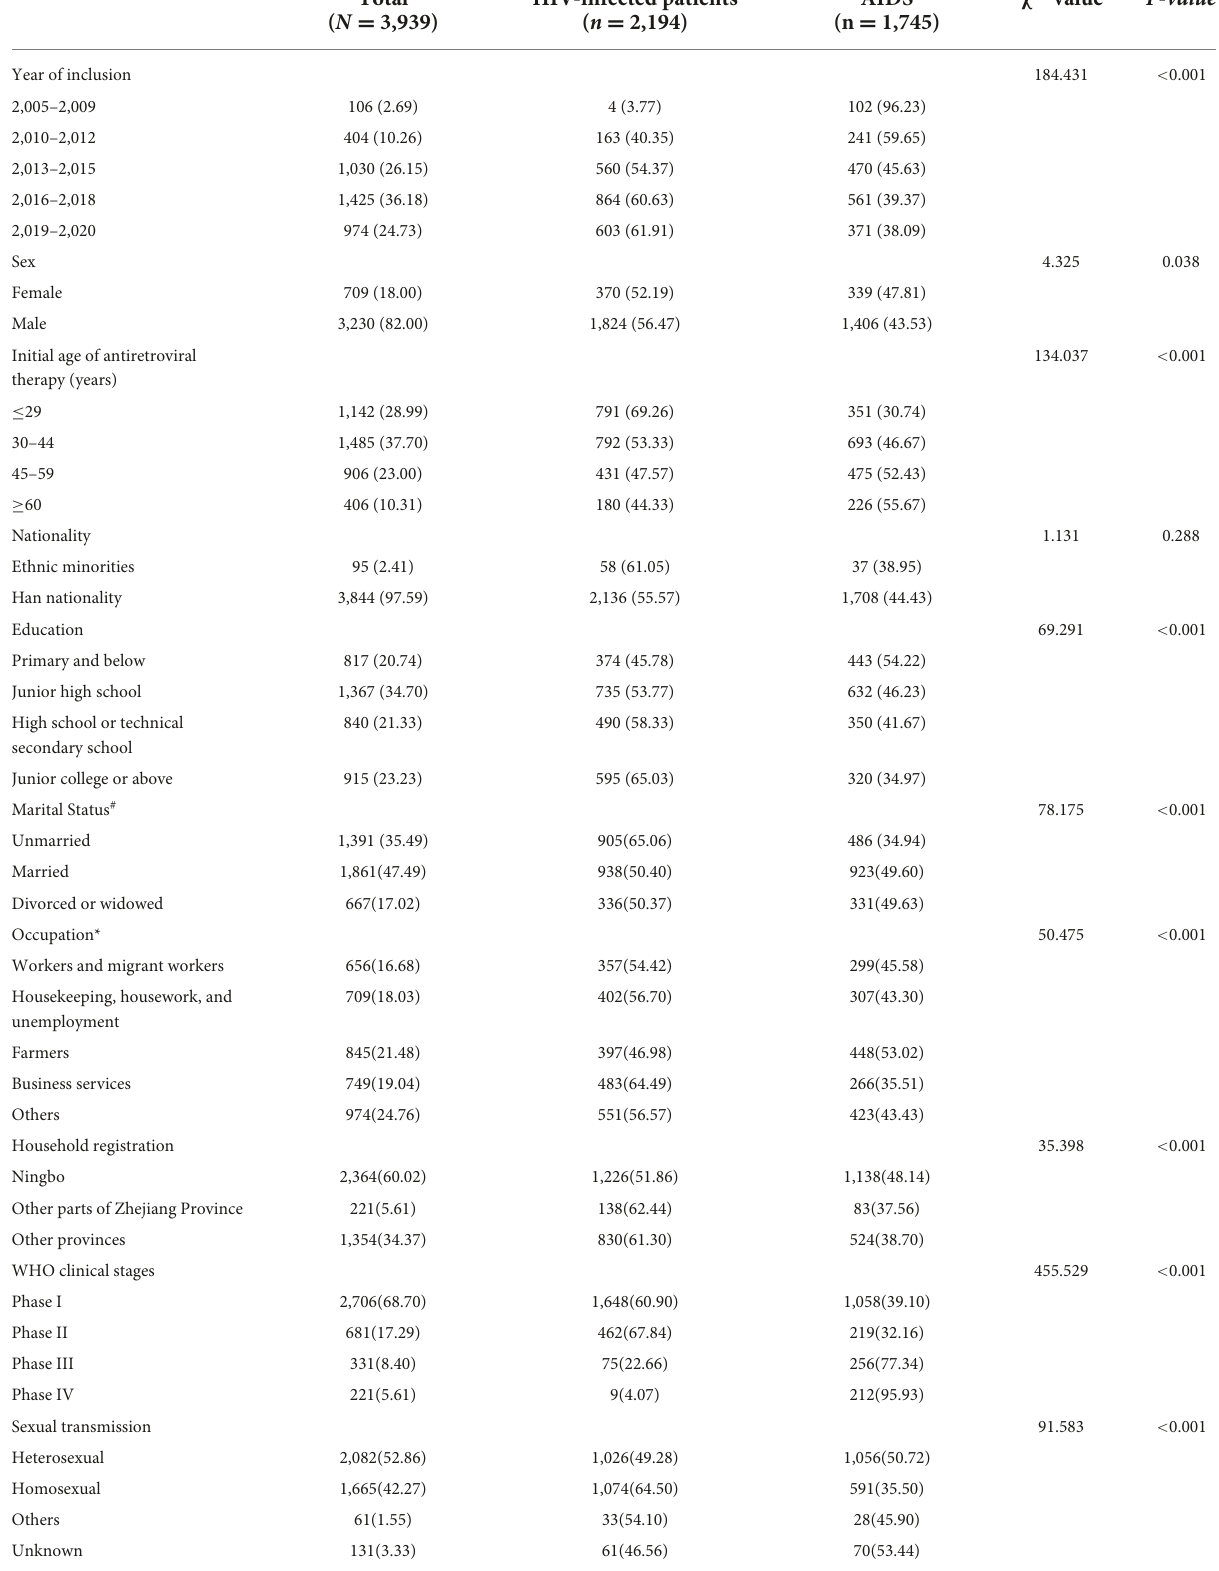
TABLE 1 Socio-demographic and related characteristics of